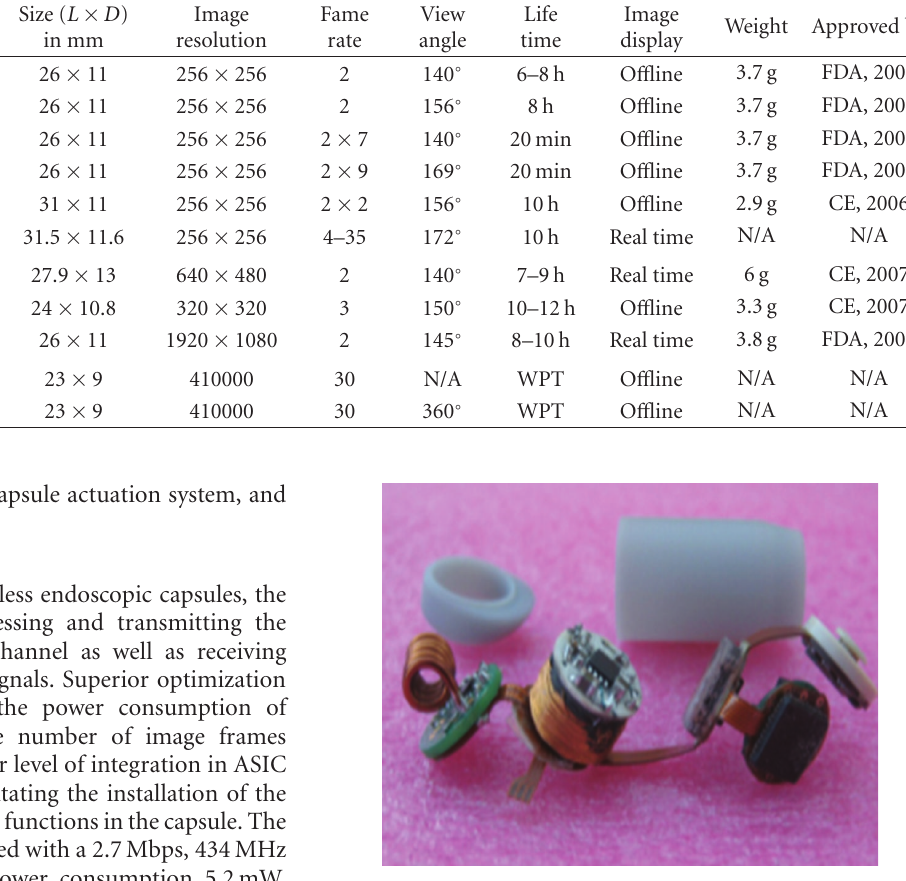
Figure 6: Prototype of an FPGA-based, miniaturized capsule